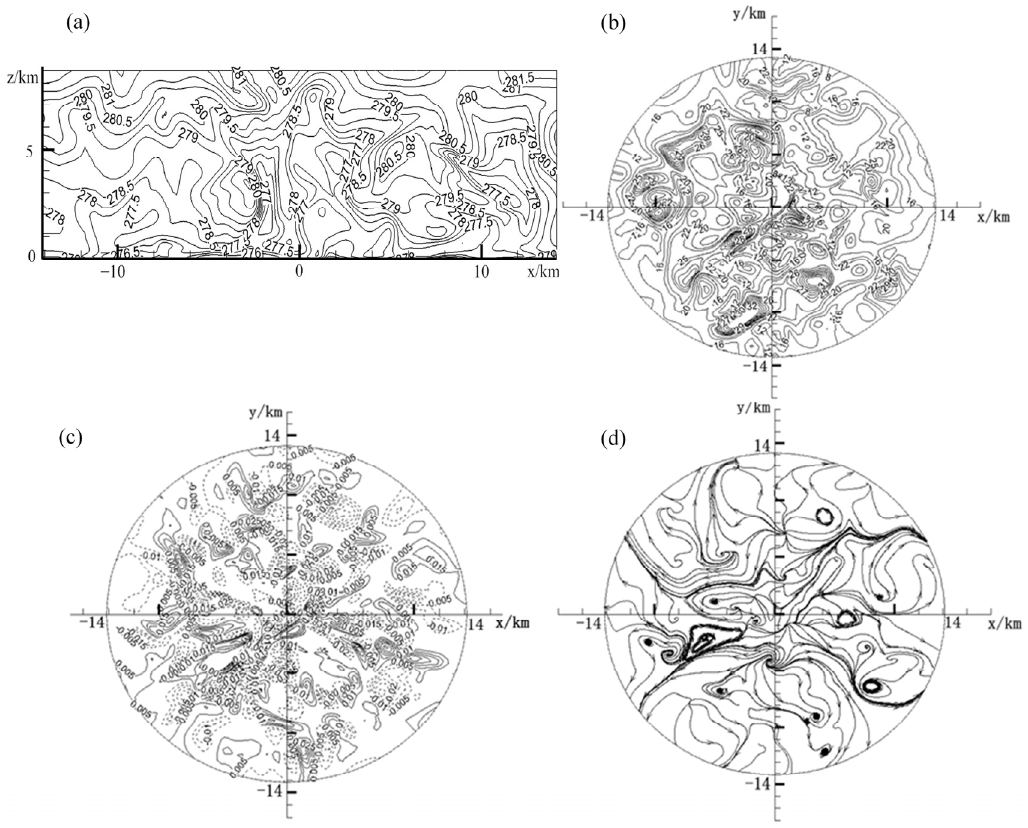
Figure 4. Air flows field at t = 1500 s. ( a ) Air temperature in the central vertical plane z–x; ( b ) horizontal velocity contours in the x–y plane, z = 1000 m; ( c ) vertical vorticities in the x–y plane, z = 1000 m and ( d ) streamlines in the x–y plane, z = 1500 m.